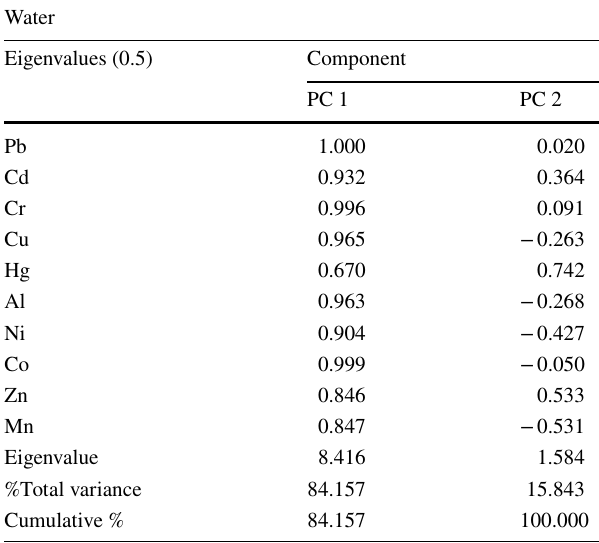
Table 7 Component matrix of two-factor model with strong to